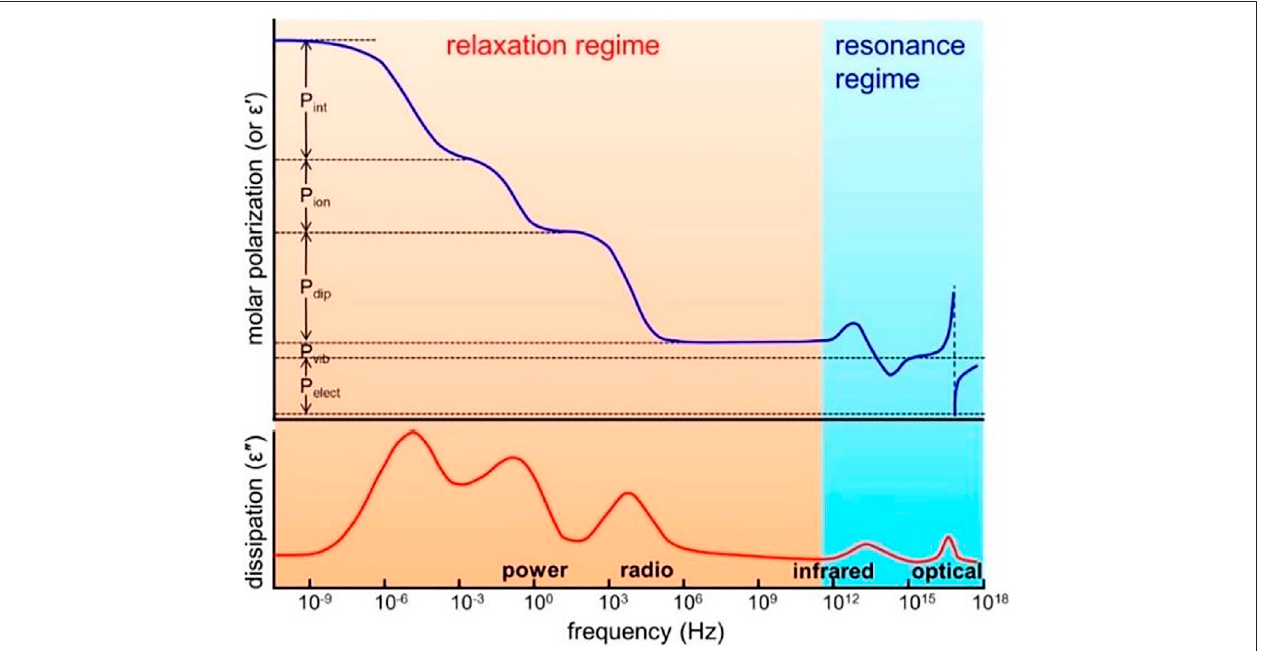
FIGURE 1 | Different types of polarization as a function of frequency in polymers. P elect , electronic polarization; P at , atomic polarization; P dip , (dipolar) orientational polarization; P ion , ionic polarization; P int , interfacial polarization. The top panel shows the molar polarization (or the real part of permittivity), and the bottom panel shows the dissipation factor (the imaginary part of permittivity). Reprinted with permission from Prateek et al. (2016). Copyright© 2016 American Chemical Society.